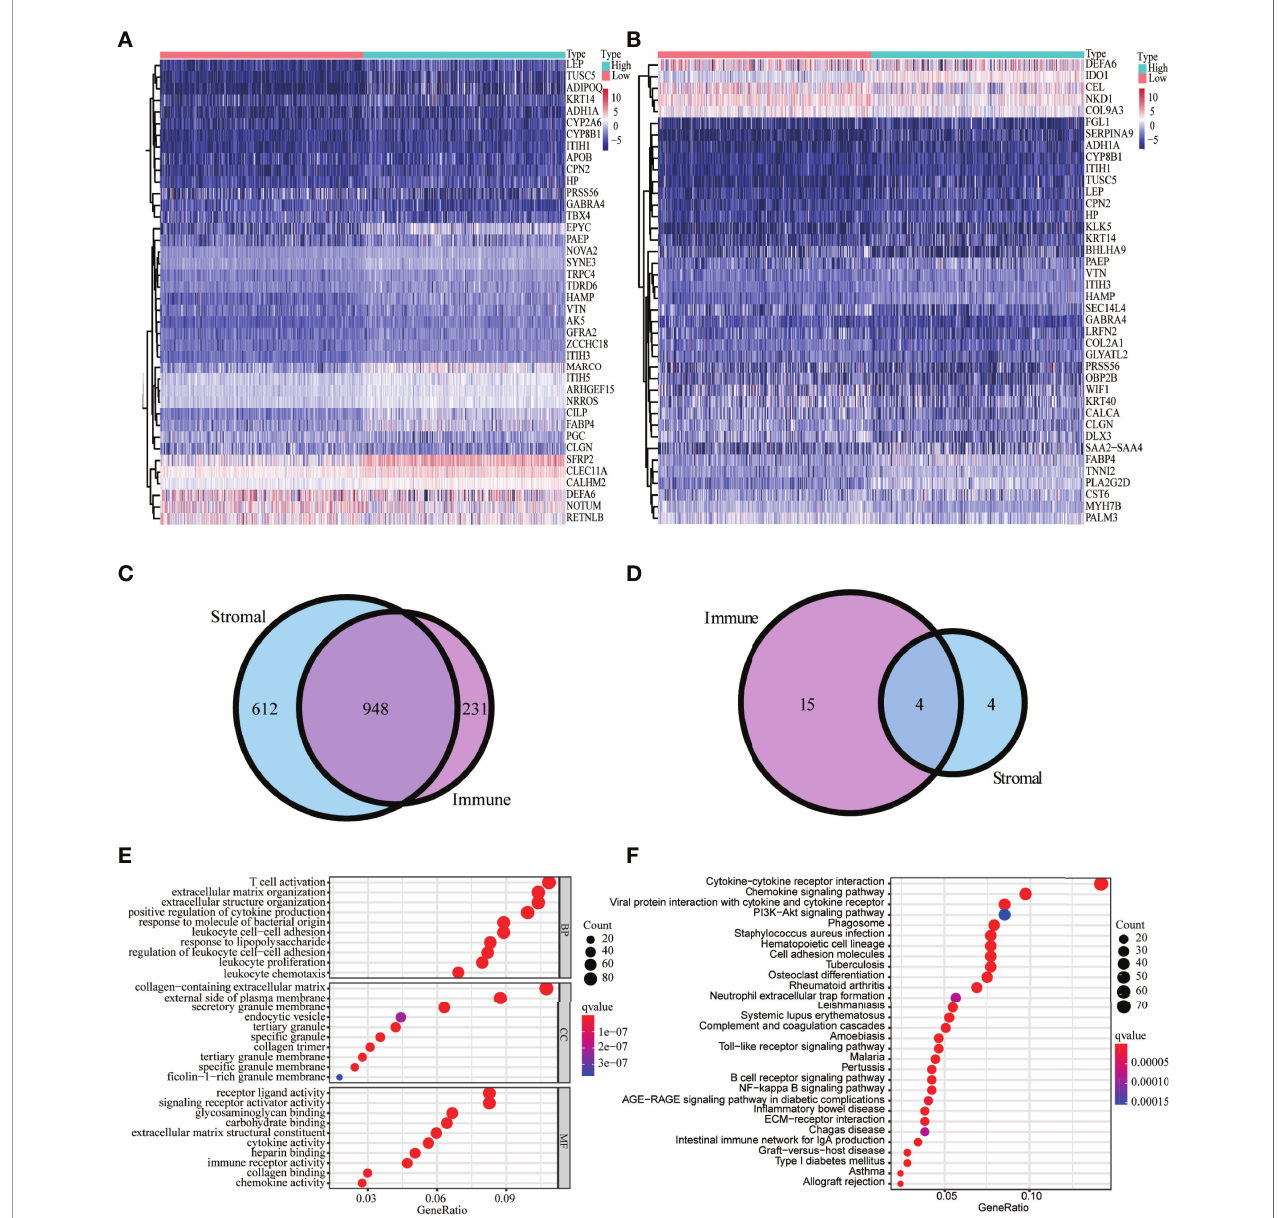
FIGURE 2 | Analysis of DEGs-based stromal and immune scores. The heatmap of the top 40 DEGs based on stromal scores (A) and immune scores (B) . Venn diagrams displaying the number of upregulated DEGs (C) and downregulated DEGs (D) detected in both groups. Top 30 enriched ( p < 0.05) GO terms (E) and KEGG terms (F)